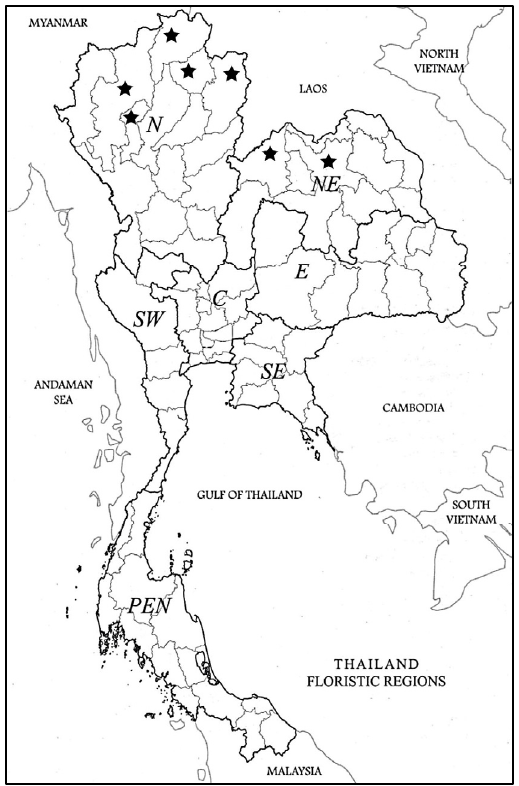
Figure 5. The distribution of Disporopsis longifolia in Thailand and the sample locations. D. longifolia is only located in the Northern (N) and North-Eastern (NE) Floristic Regions. Floristic regions defined in [31]. It is also found in China, Myanmar, Laos and Vietnam.